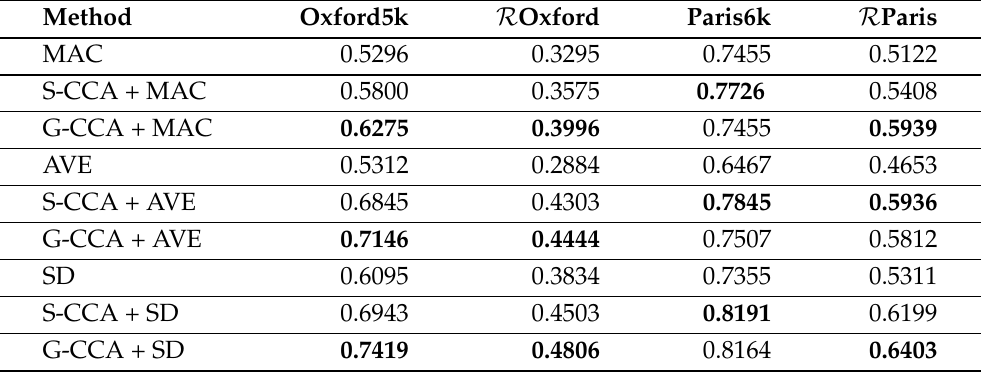
Figure 6. A 3D visualization of matrix Π . Table 2. Performance comparison of the baseline, S-CCA, and G-CCA on Oxford5k, R Oxford, Paris6k, and R Paris without dimension